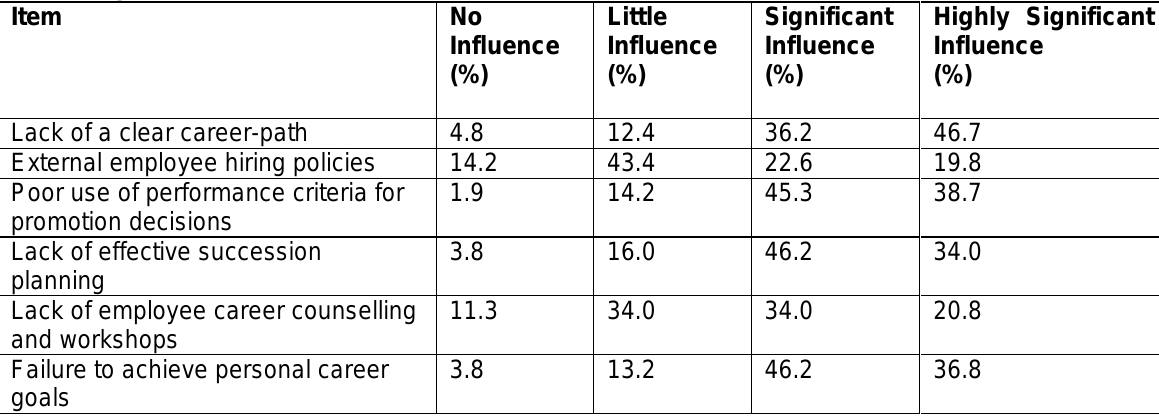
Table 5: Perceived influence of career-path strategies being used by South African organisations on the respondents’ consideration to